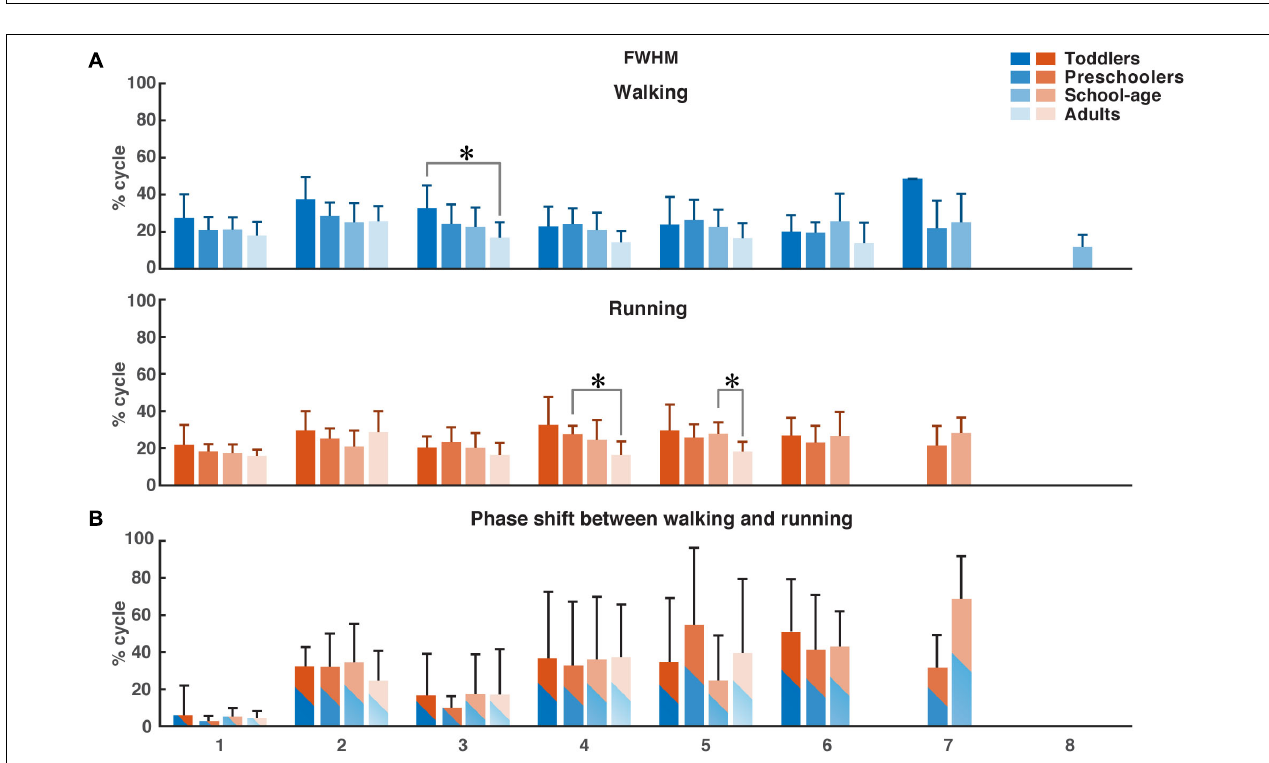
FIGURE 4 | Muscle synergy structure for the four groups for walking (left; in blue ) and running (right; in red). Vertical dotted line in activation timing plots represents the end of the stance phase. Each colored line represents a participant side, leading to one line for right side and one line for left side for each participant resulting in a total of ( n = 10) for the toddler group, ( n = 12) for the preschoolers, ( n = 24) for the school-age group, and ( n = 14) for the adult group. Black lines represent the mean. Y-axis is in arbitrary units. In the weighting plots, each colored bar represents the weighting coefficient for one participant side, the weightings are ordered based on their size. The black outlines represent the mean for the group. TA, tibialis anterior; MG, gastrocnemius medialis; BF, biceps femoris; VMO, vastus medialis oblique; RF, rectus femoris; TFL, tensor fascia latae; GM, gluteus maximus; ES, erector spinae; LD, latissimus dorsi; AD, anterior deltoid; PD, posterior deltoid; TRAP, trapezius; TB, triceps brachii; BB, biceps brachii; and BR, brachioradialis.